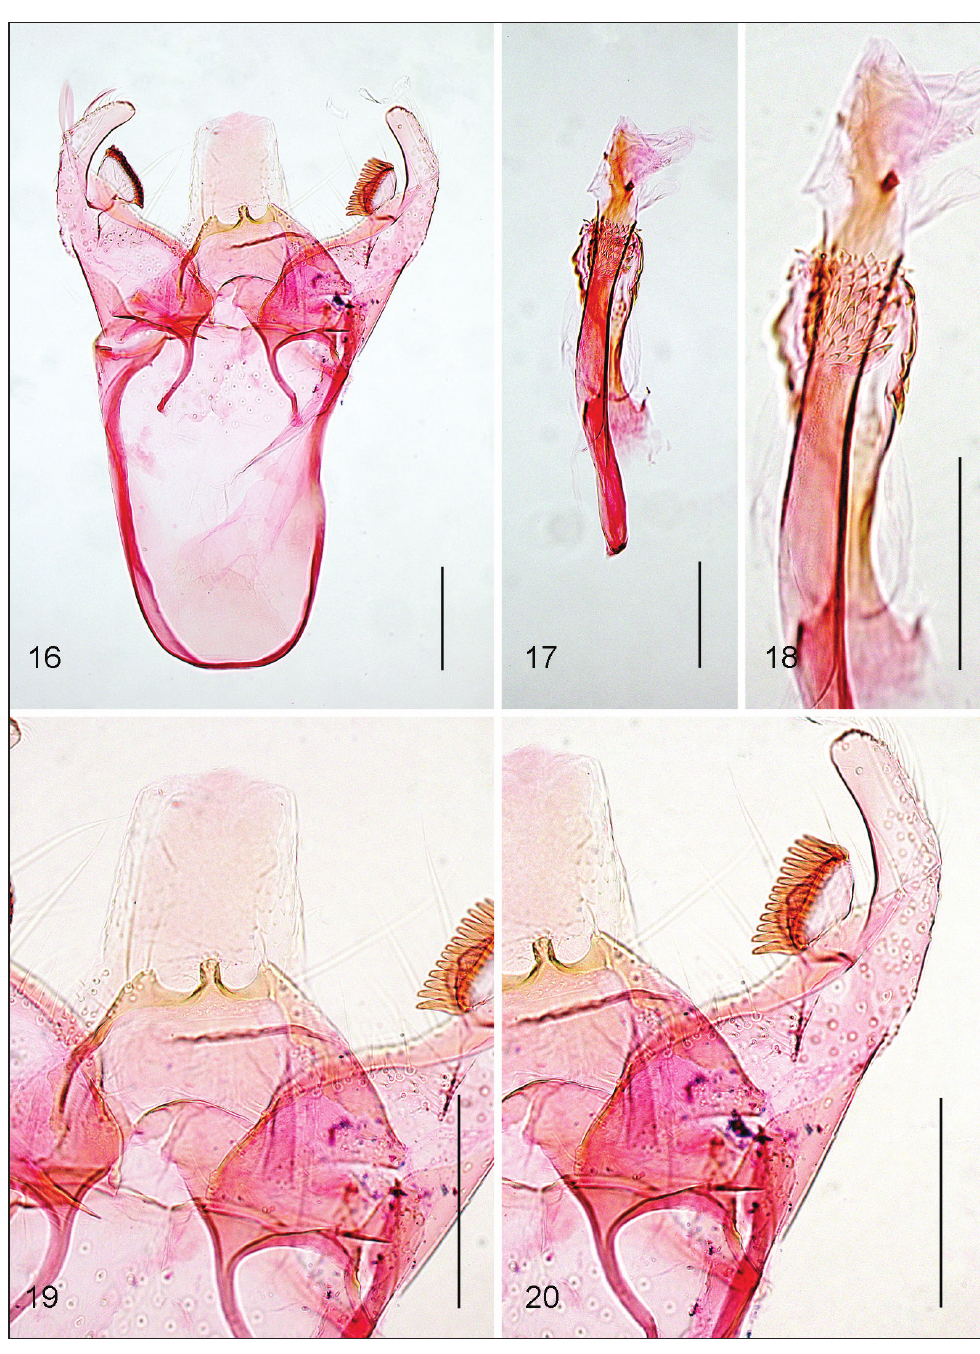
Figures 16–20. Antispila treitschkiella , male genitalia, slide JCK8059. Scales 100 μm (16–17), 50 μm (18–20). Photos Erik van